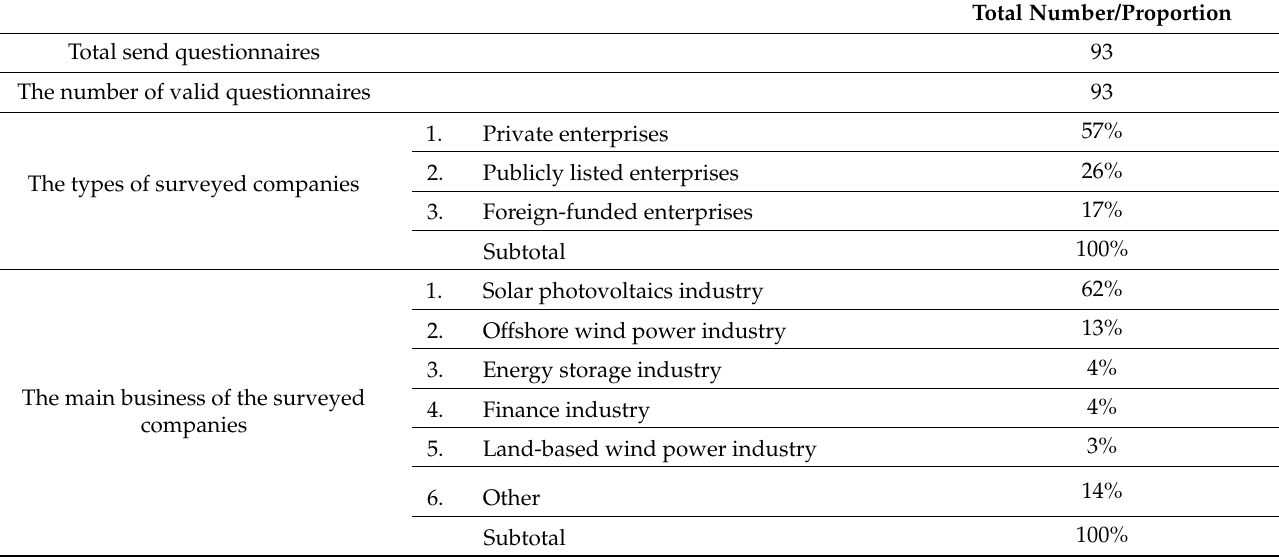
Table 4. The sample descriptive